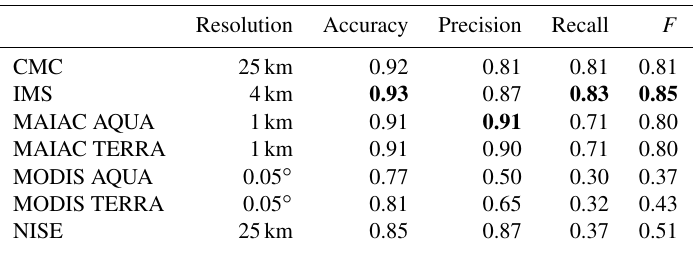
Table A2. Evaluation of daily snow extent data set performance for 2015. GHCN-D surface observations are used as “truth”. The highest value for each metric is shown in bold.